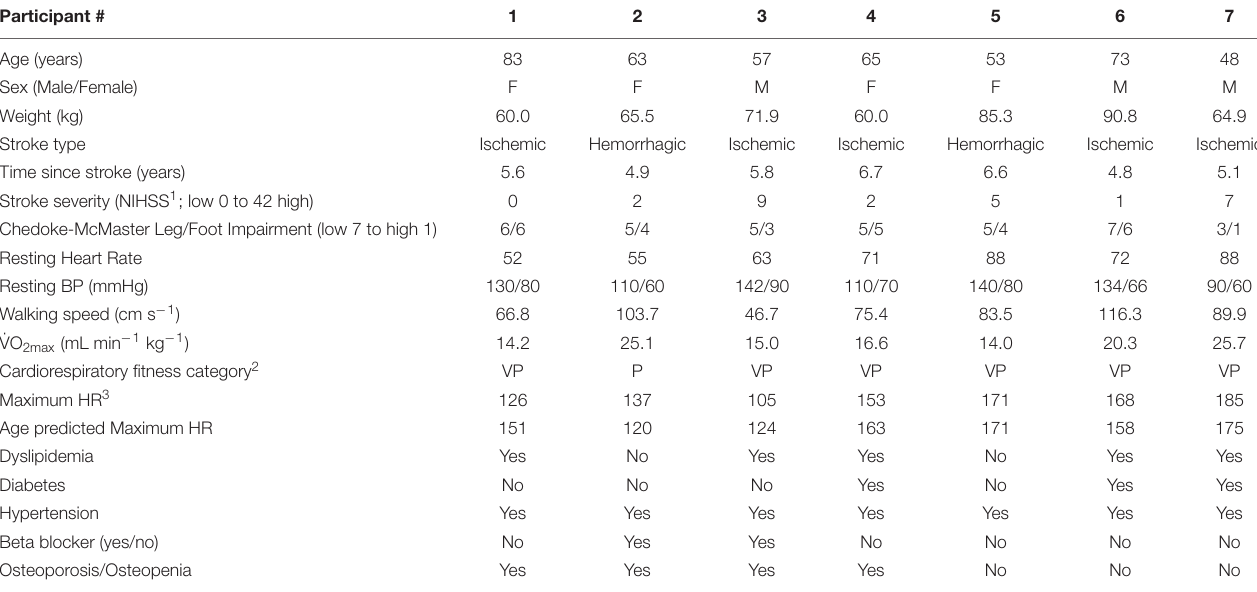
TABLE 1 | Participant